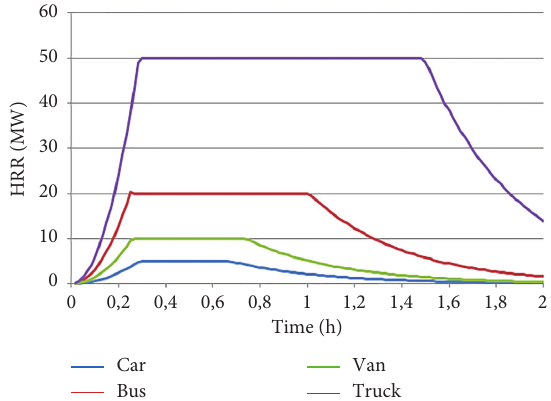
Figure 5: Model curves of the heat power of the